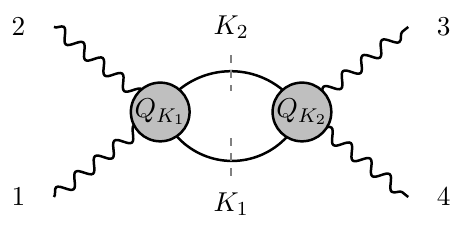
Figure 5 . The four-point bubble diagram is formed by gluing two tree-level four-point superam- plitudes. We identify K 1 as loop momentum ( K 1 = ‘ ), then the on-shell conditions ( K 2 be read as ‘ 2 = 0, and ( ‘ + k 1 + k 2 ) 2 =